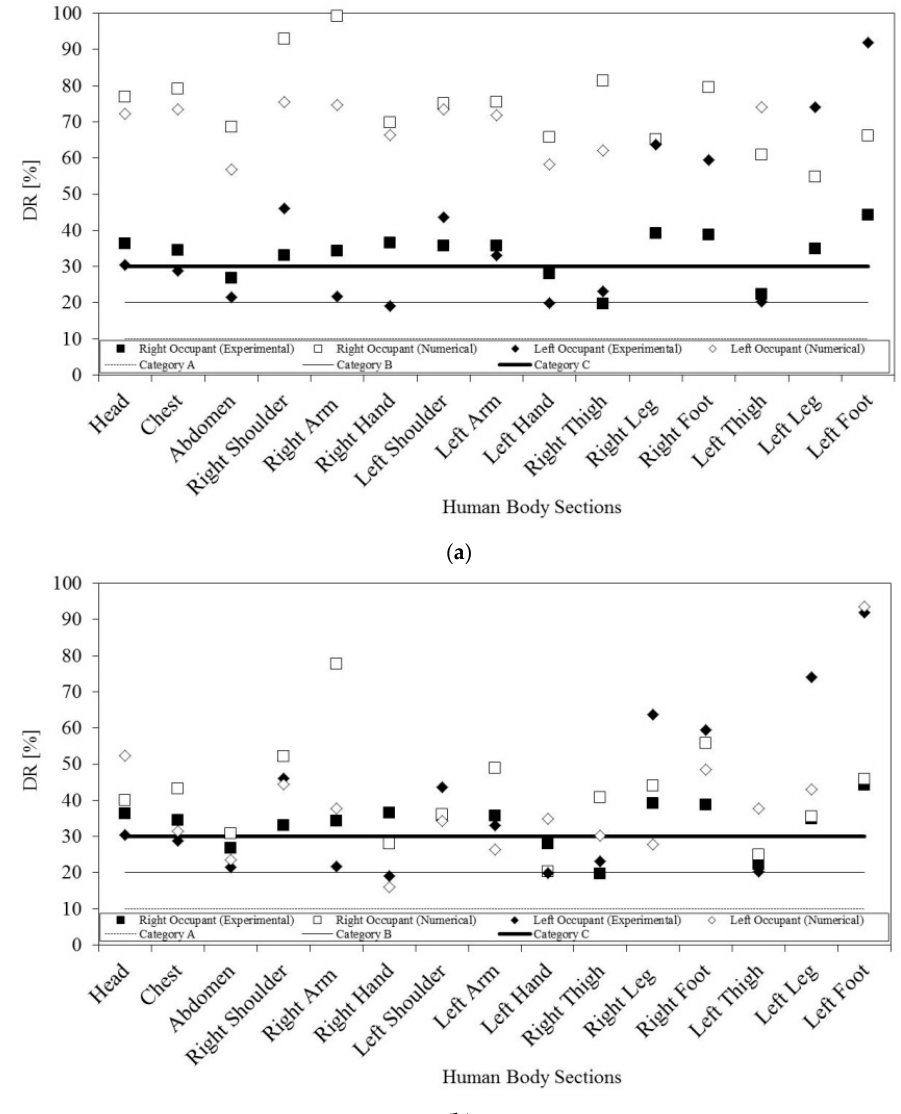
Figure 10. Draught risk (DR) around the occupants numerically calculated and experimentally measured. In ( a ), the k ‐ epsilon turbulence model is used, and in ( b ), the RNG turbulence model is applied.